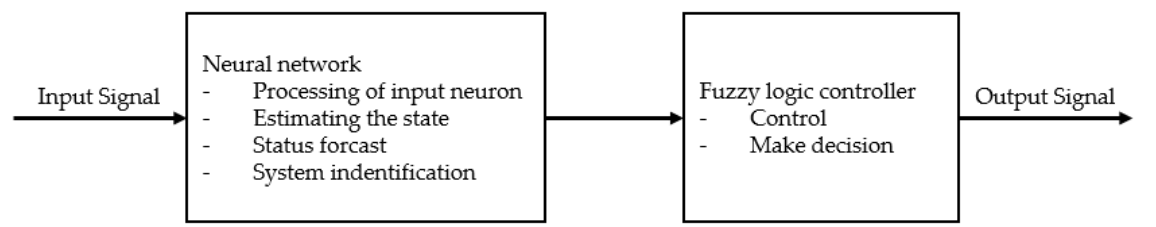
Figure 3. Model architecture of a neural-fuzzy system.